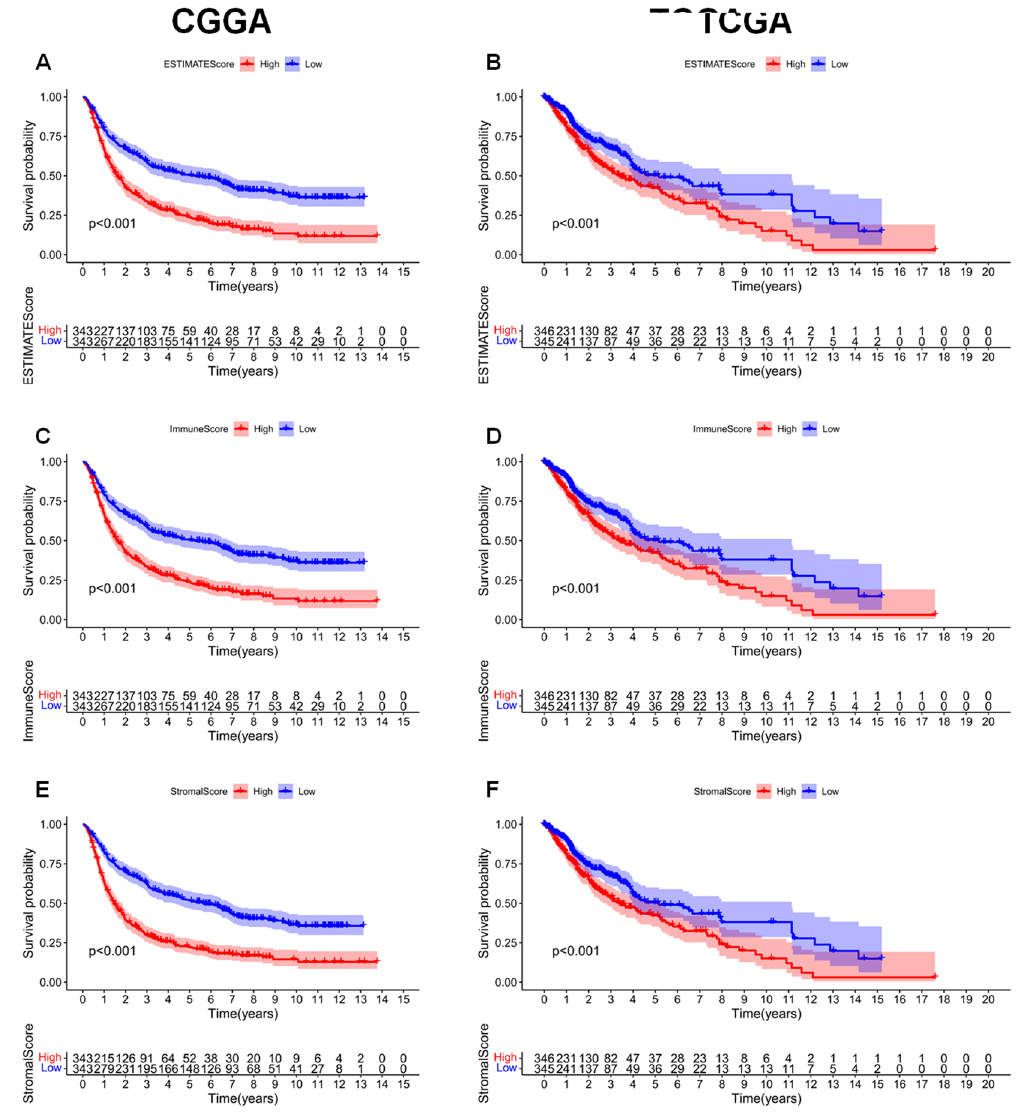
Figure 6. Kaplan–Meier survival curves of ESTIMATEScore, ImmuneScore, and StromalScore. High levels of ( A , B ) ESTIMATEScore, ( C , D ) ImmuneScore, and ( E , F ) StromalScore correlated with poor